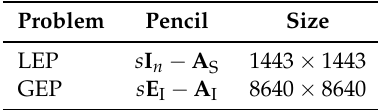
Table 6. AIITS: dimensions of the LEP and GEP.